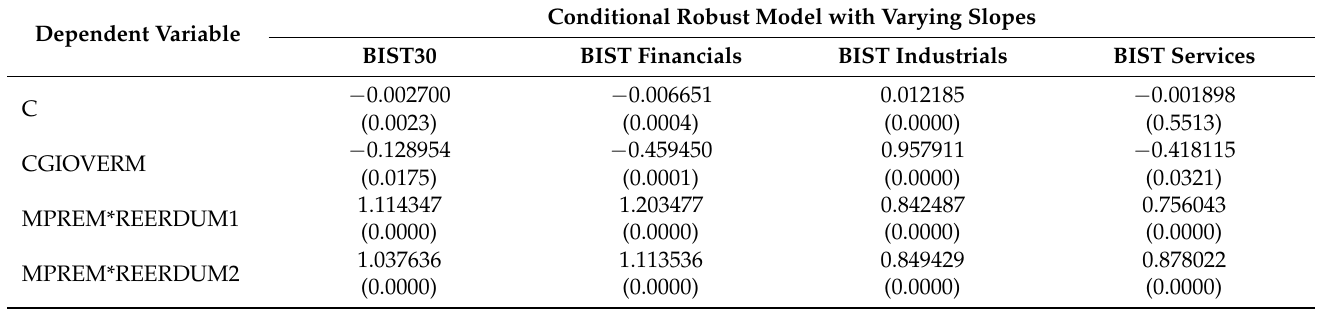
Table 5. Robust regression models: summary and